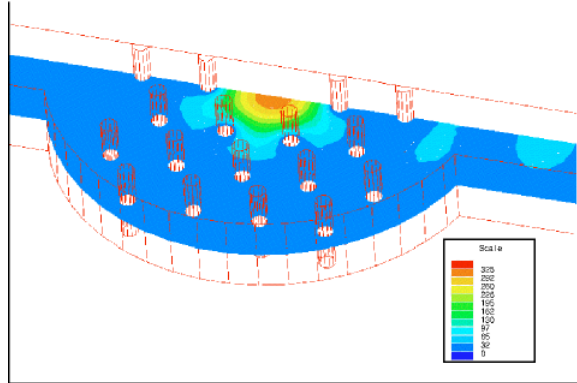
FIG. 2. (Color) The HFSS model of the PBG cavity and the waveguide coupling unit showing the magnitude of the electric field. The WR62 waveguide on the right is used for coupling the rf power into the cavity, and a similar waveguide is used on the left to symmetrize the system. The PBG cavity and the waveguides are cut along the plane of symmetry which is specified as an H wall in the